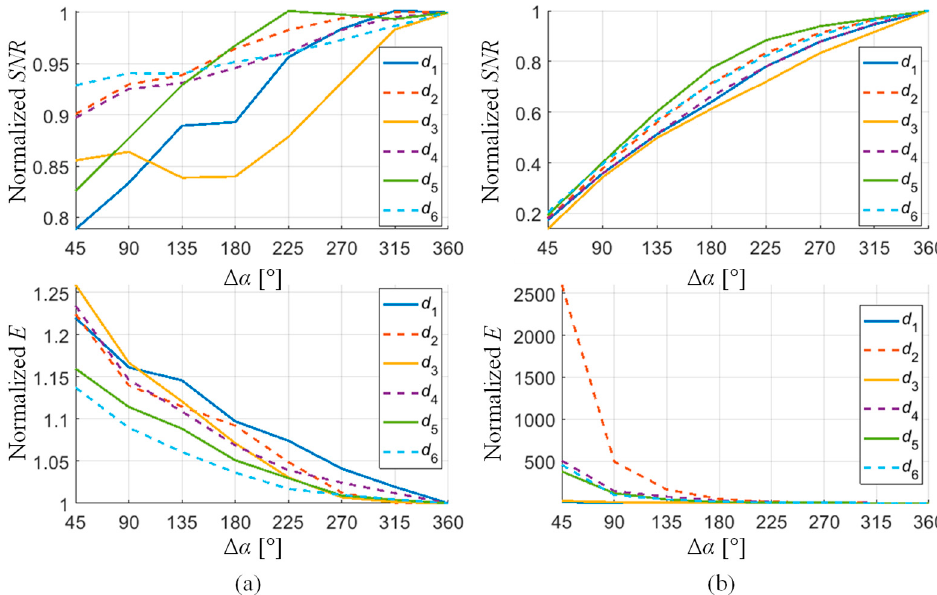
Figure 17. Changes of SNR and E coefficient levels in response to the increase of the angular measuring range of a single sensor from 45° (complementary data) to 360° (redundant data): computed for DF PYR ( a ) and DF IOP ( b ).